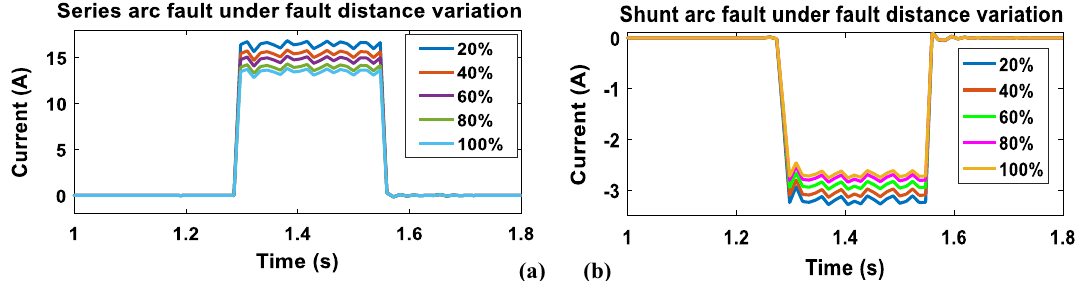
Fig. 10 Series and shunt arc faults in PV arrays a series arc fault, b shunt arc